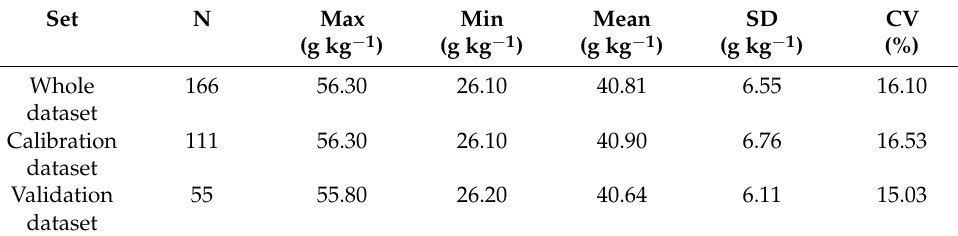
Table 2. Statistical descriptions of the SOM contents on the whole, calibration and validation